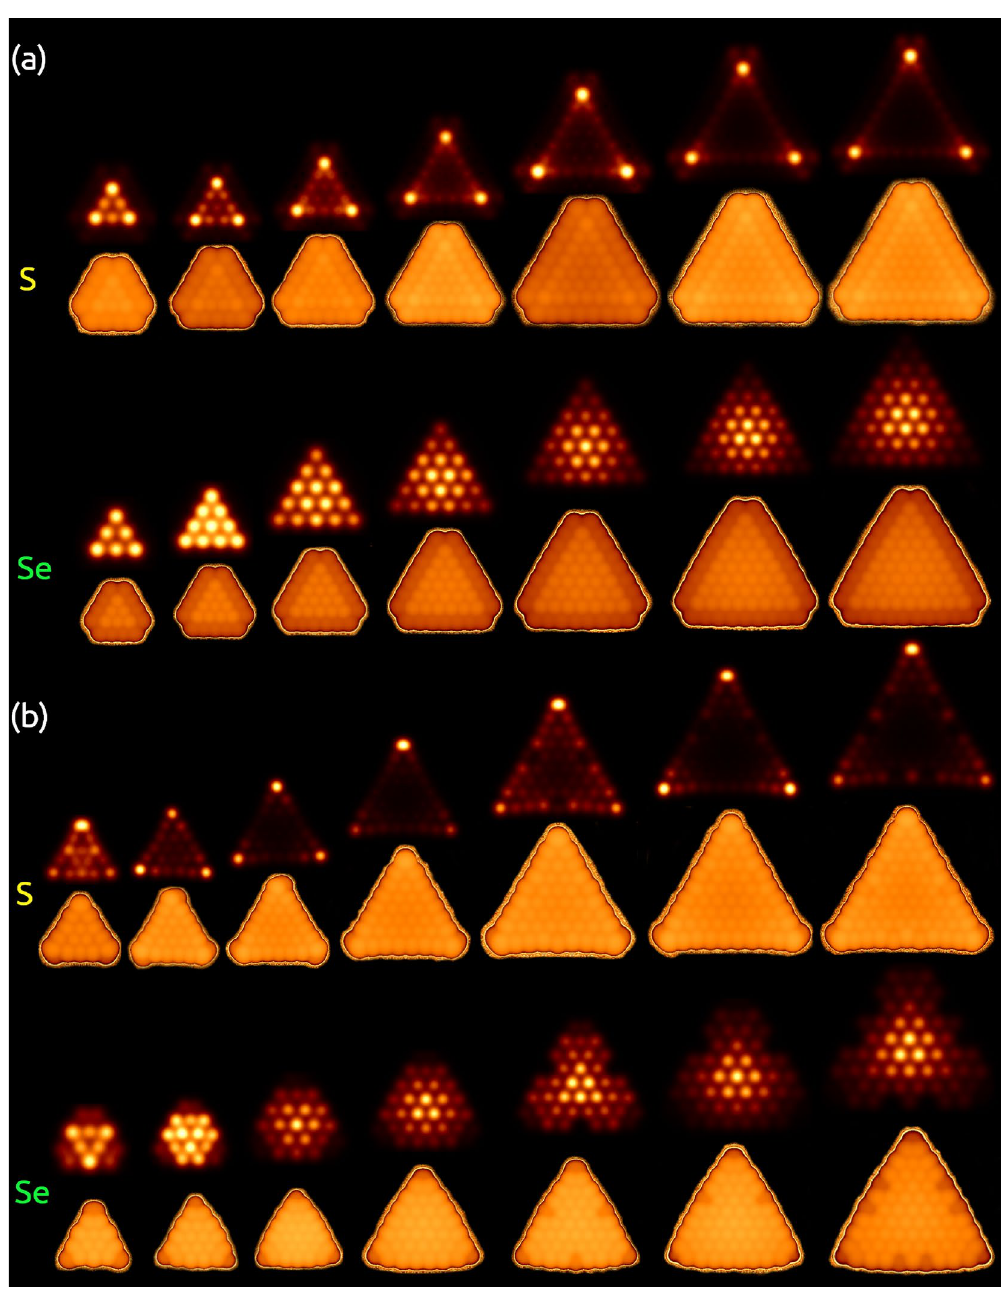
Figure 5. Tersoff-Hamman STM images unravel the atomic-scale details of the C1(n) and C2(n) with n = 4–10. The images presented were obtained by constant height and constant current modes over both faces of the Janus MoSSe quantum dots. ( a ) C1(n), and ( b )